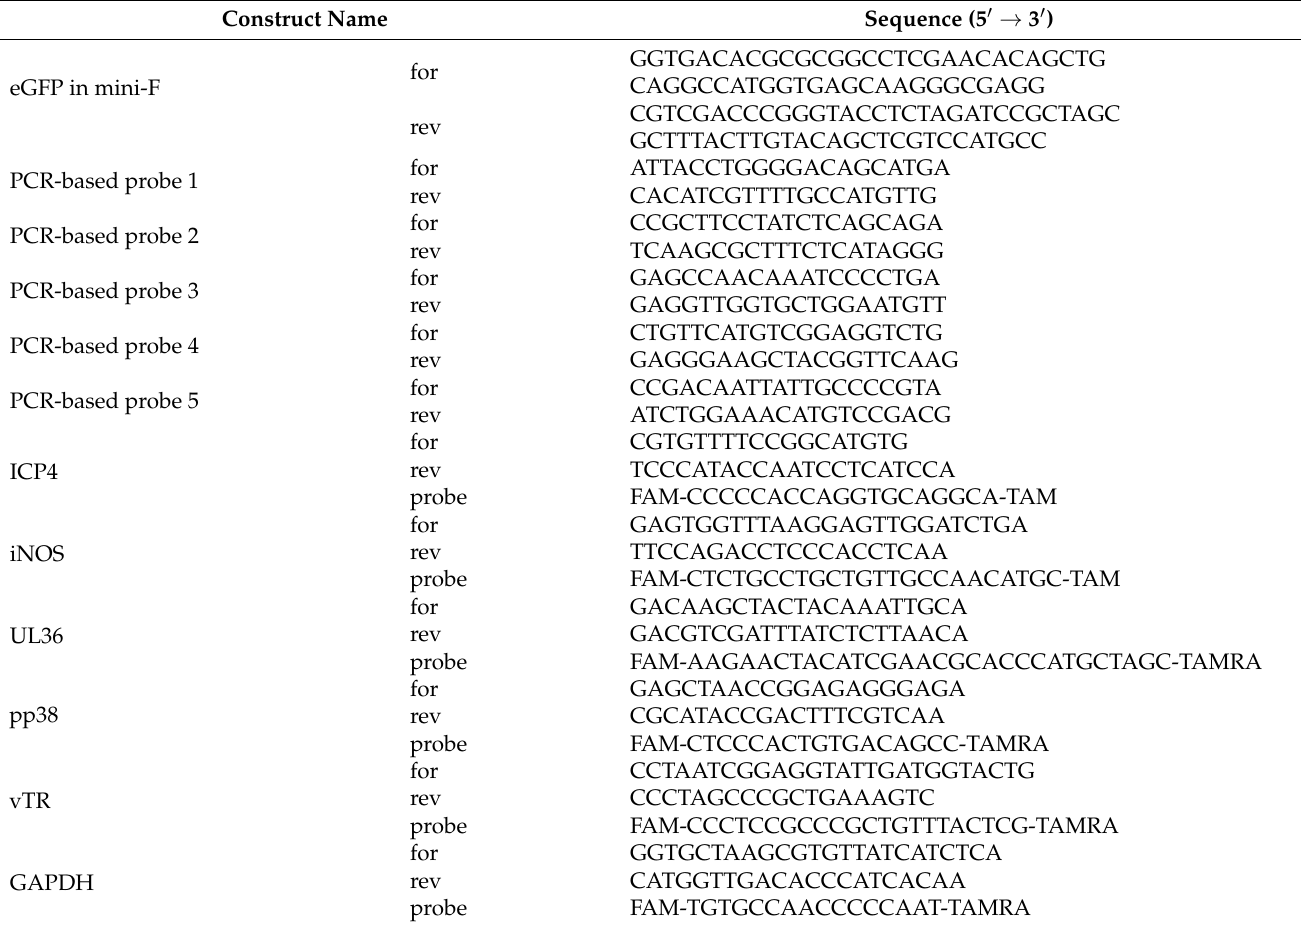
Table 1. Primers and probes used in this